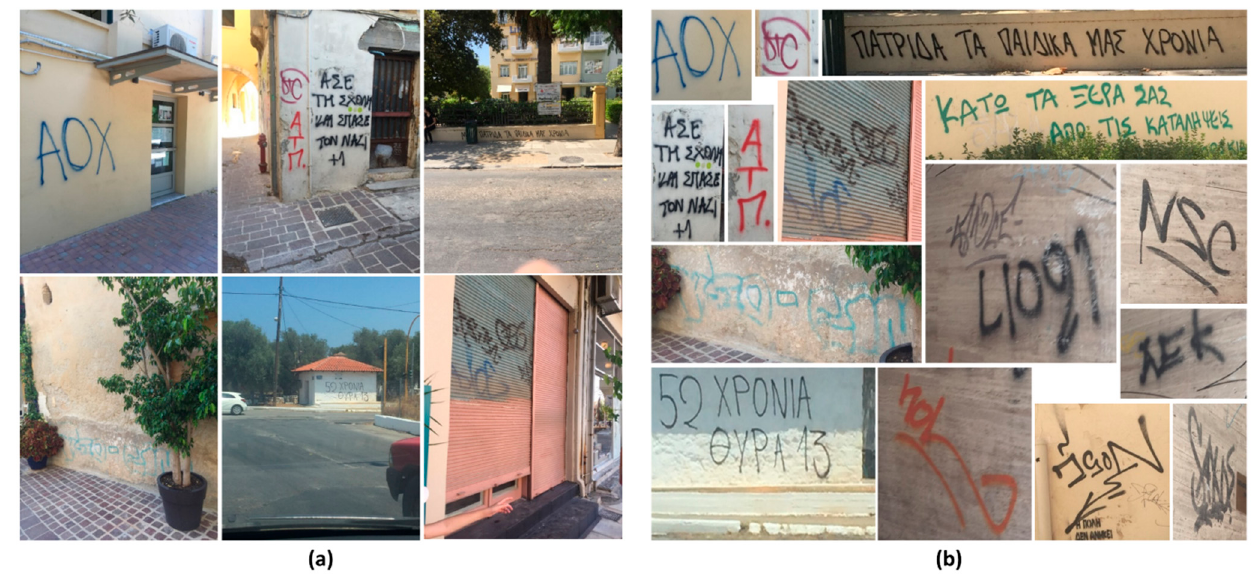
Figure 6. Graffiti dataset provided by the STORM project and used for training the graffiti detector: ( a ) sample images from the database of graffiti scenes in a community; and ( b ) samples of graffiti markings in our ground-truth dataset identified by three individuals on our team with cross-validation.